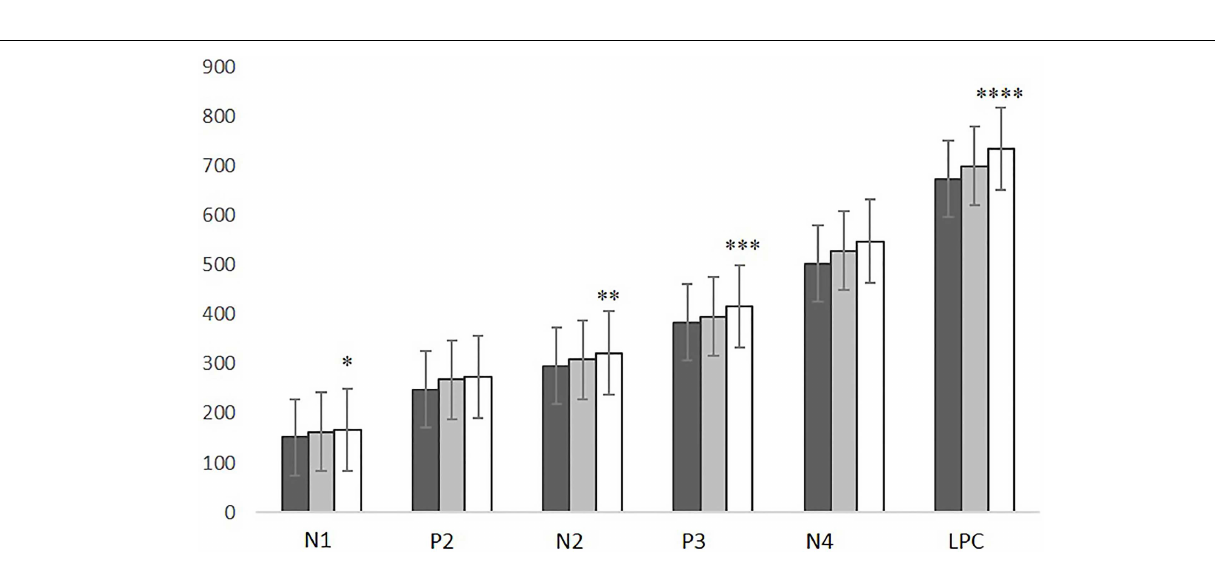
FIGURE 3 | N1, P2, N2, P3, N4, and LPC latencies in CNT subjects (black), SLP patients (gray), andALS patients (white) . ALS vs. CNT: * p = 0.021; ** p = 0.043; *** p = 0.036; **** p = 0.004. Line bars over each column indicate Standard